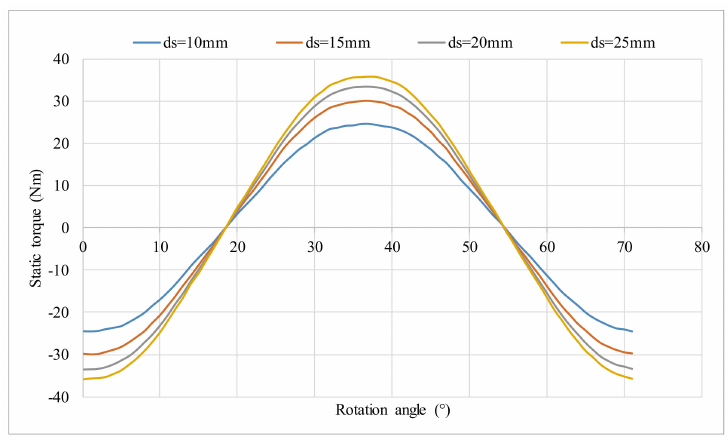
Figure 8. Stator thickness influence on the torque size of the machine.